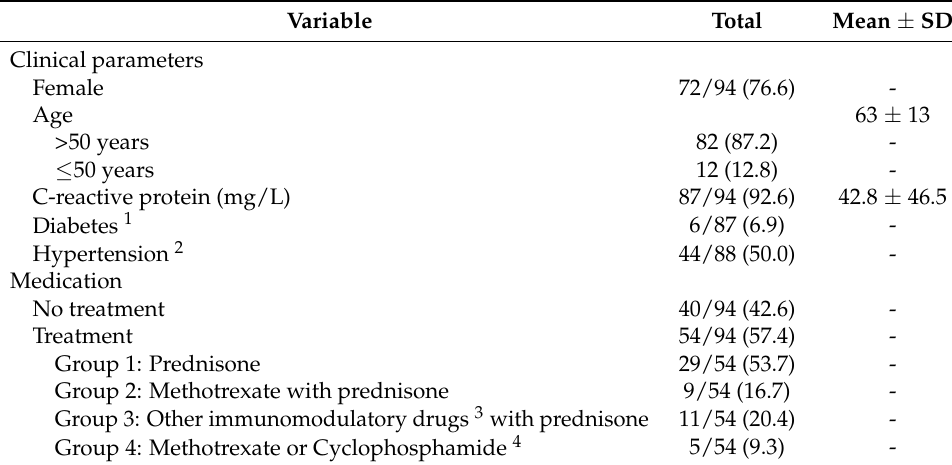
Table 1. Patient characteristics. Percentages are given in